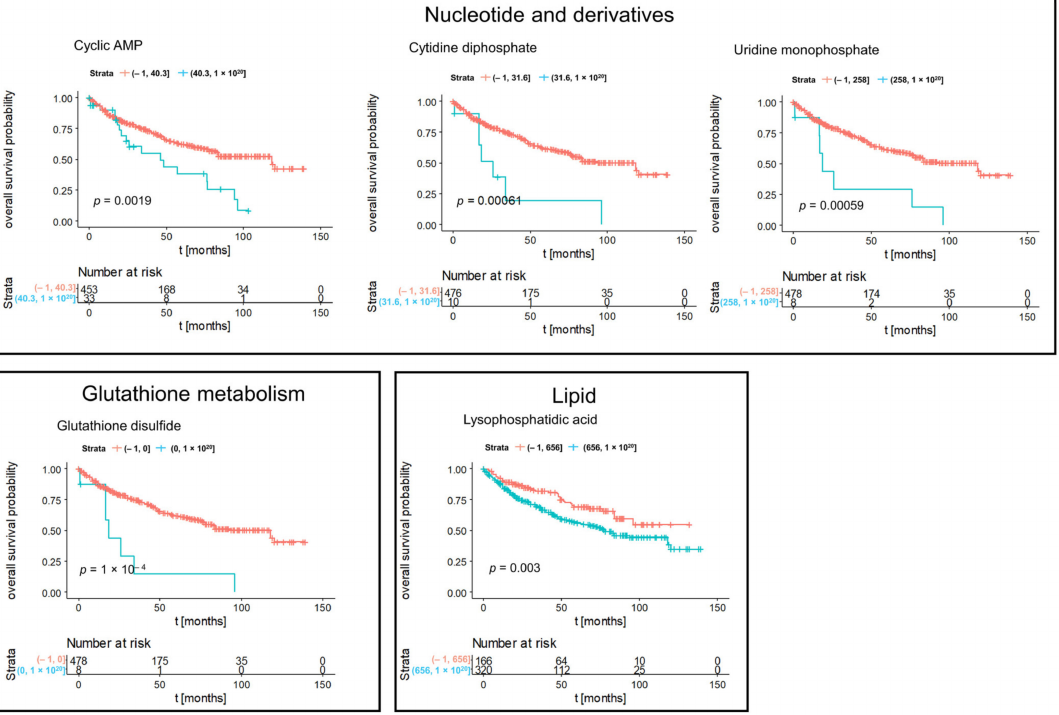
Figure 6. Kaplan–Meier significant metabolites specific for subtype ccRCC. Blue lines indicate survival in patients with high intensity of the respective mass. Red lines indicate survival in patients with low intensity of the respective